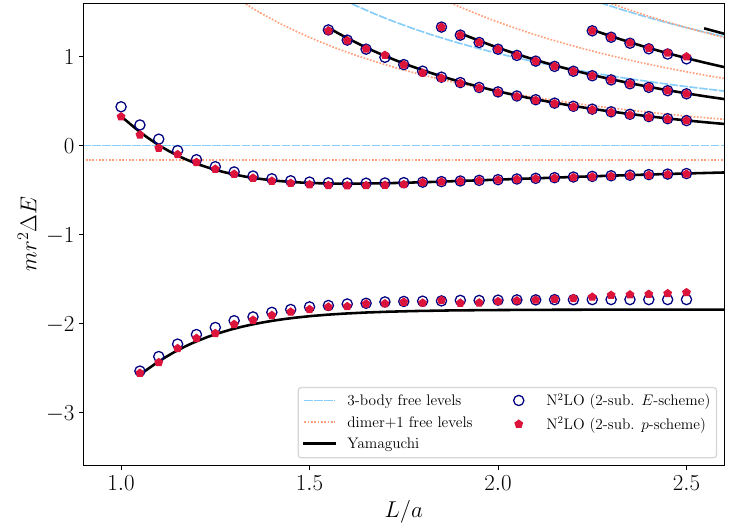
Figure 5 . Comparison of the EFT finite volume energy spectrum in the p - and E -schemes at N 2 LO with 2 subtractions and the Yamaguchi results. For explanation of symbols and lines see